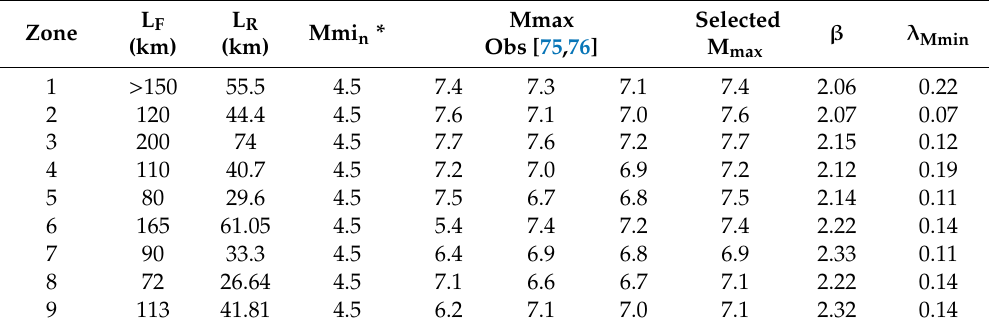
Table 1. Seismicity parameters for the selected seismic area